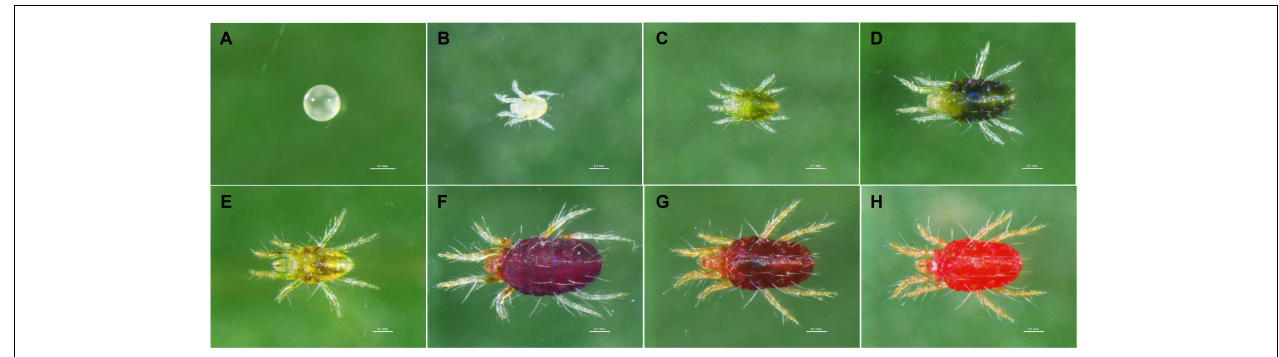
FIGURE 2 | The morphology of A. viennensis under different intrinsic conditions. The developmental stages include egg (A) , larvae (B) , protonymph (C) , and deutonymph (D) . Sex includes male (E) and female (F) . Diapause stage includes the normal adult females (F) , pre-diapause females (G) , and diapause females (H) . The scale bar presents 0.1 mm.